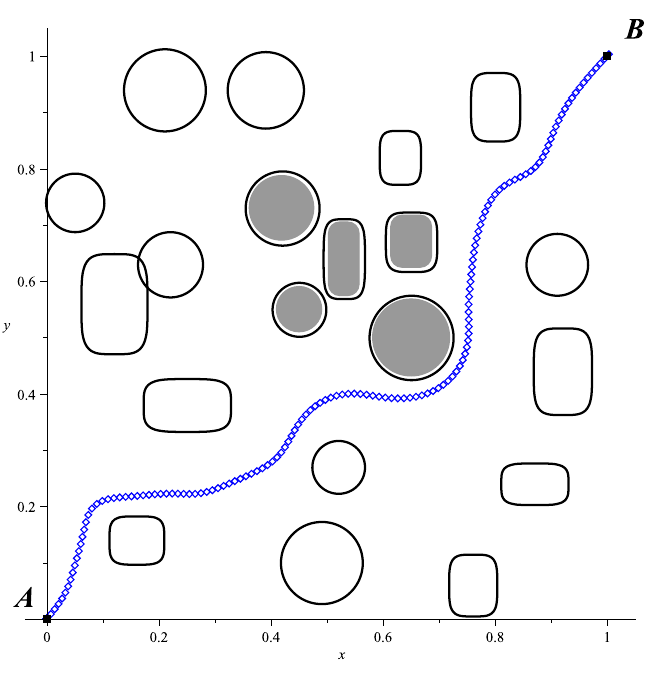
Figure 12. Homotopic path calculated in